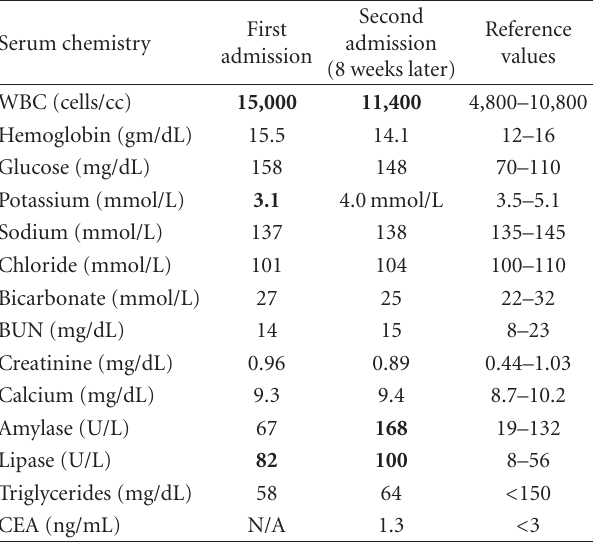
Table 1: Laboratory